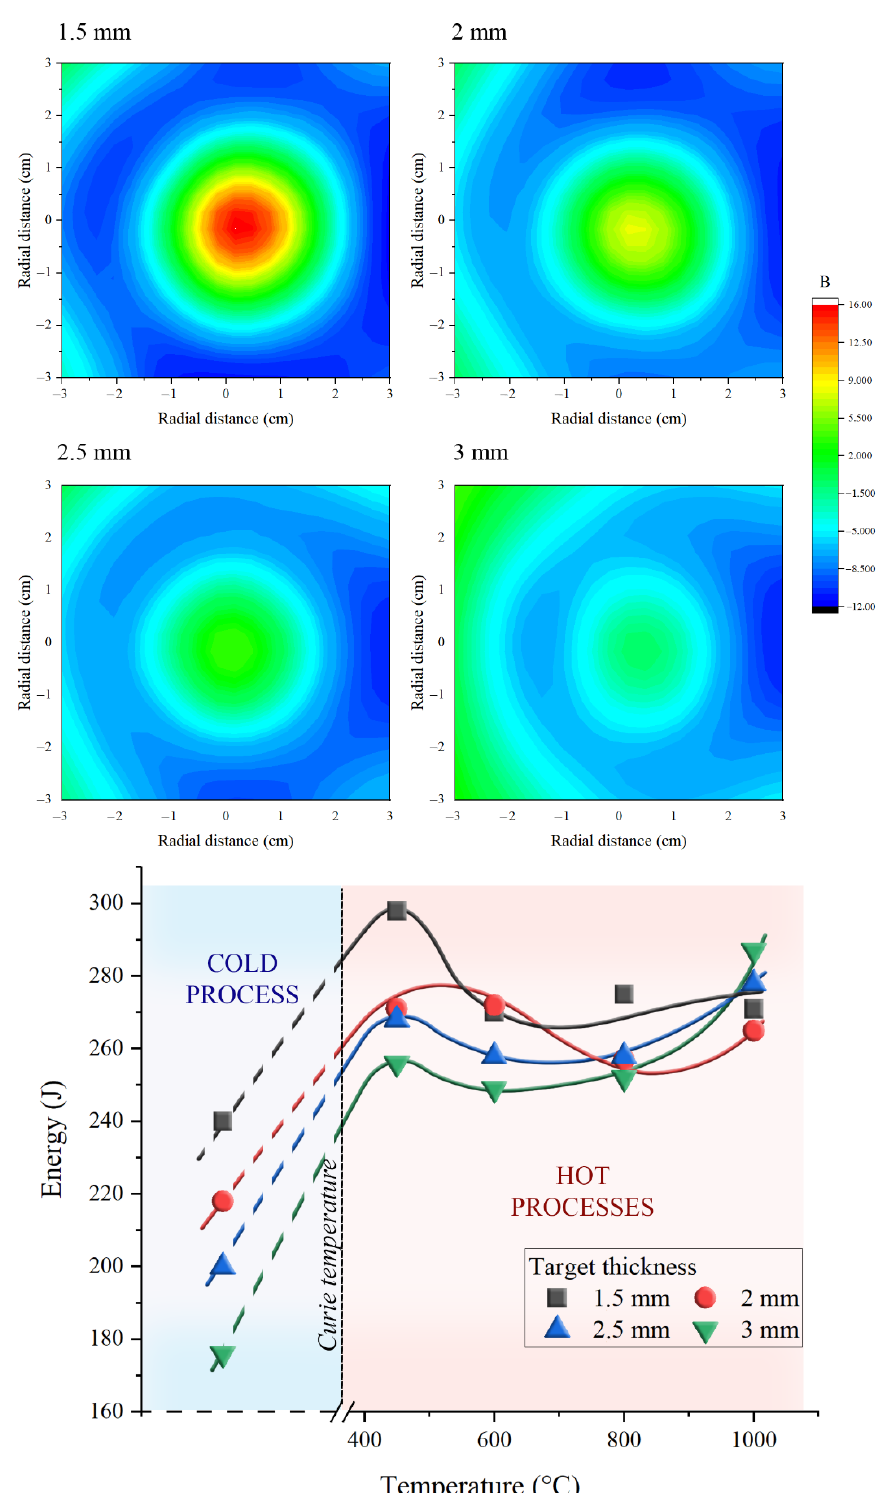
Figure 3. Distribution of B ⊥ at the surface of nickel targets with various thickness and characteristics of plasma pulse energy during the sputtering process .